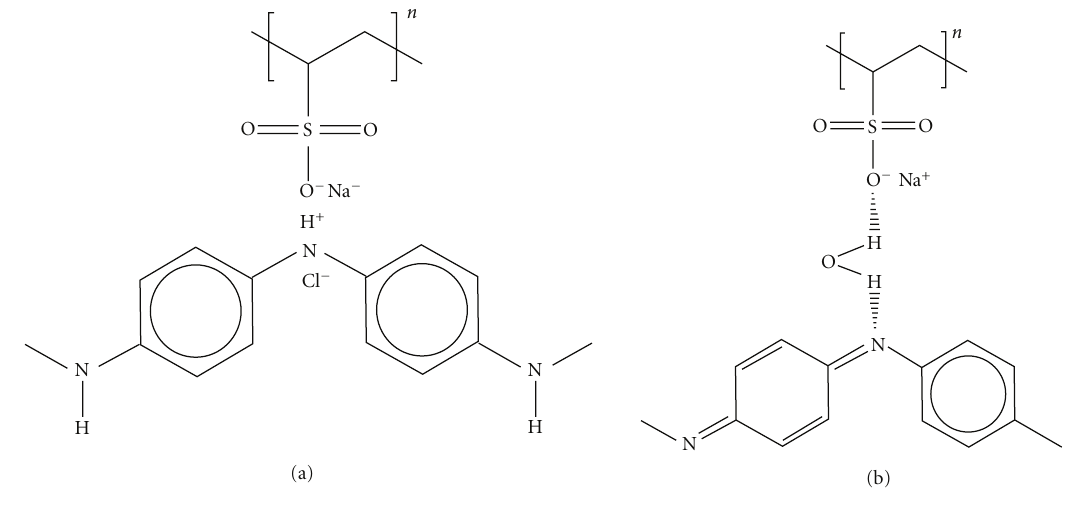
Scheme 2: Representation of the mechanisms of the adsorption process proposed for the PANI and PVS: (a) adsorption in the presence of electric charge and (b) adsorption in the absence of electric charge [26].